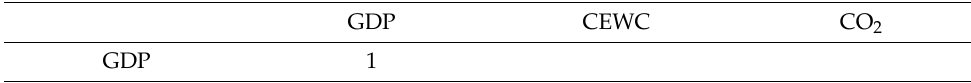
Table 2. Cont . (c) Correlation Matrix for Selected Visegrad 4 (V4) Countries of Europe GDP CEWC